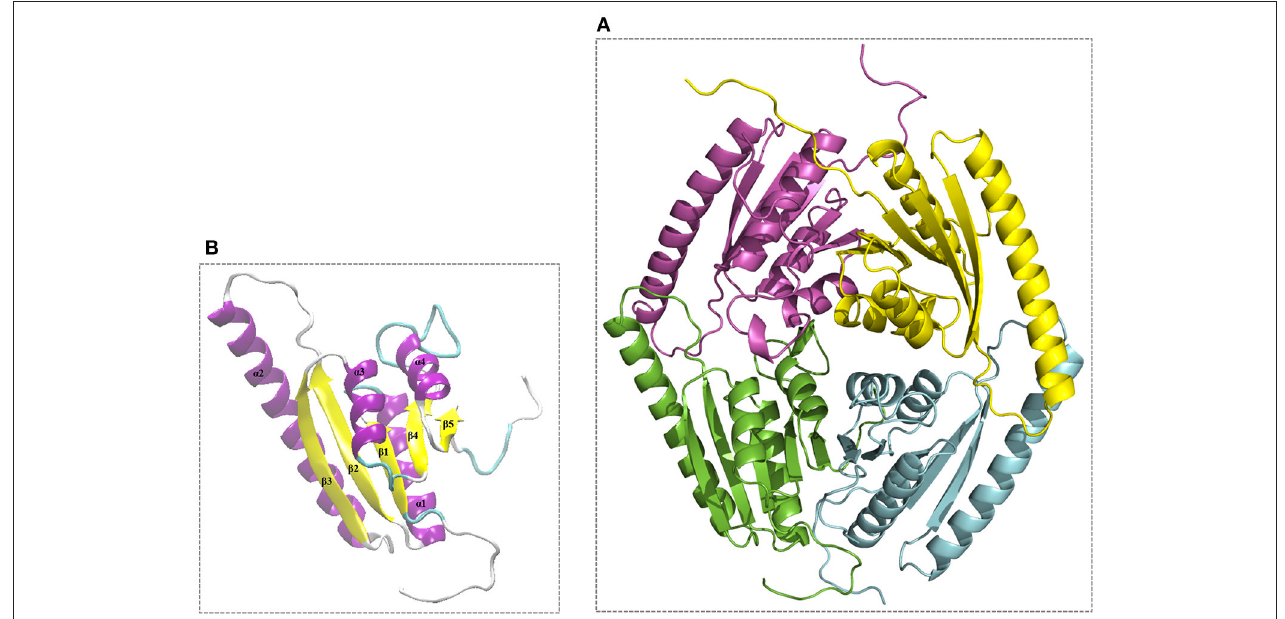
FIGURE 6 | Overall 3D structure of the Model_USP-691 from L. innocua ATCC 33090. (A) 3D representation of tetrameric conformation containing the chain_A (green), chain_B (cyan), chain_C (magenta), and chain_D (yellow). (B) , representation of architecture having reference to the Rossmann-like α / β -fold with five parallel β -strands and four α -helices.